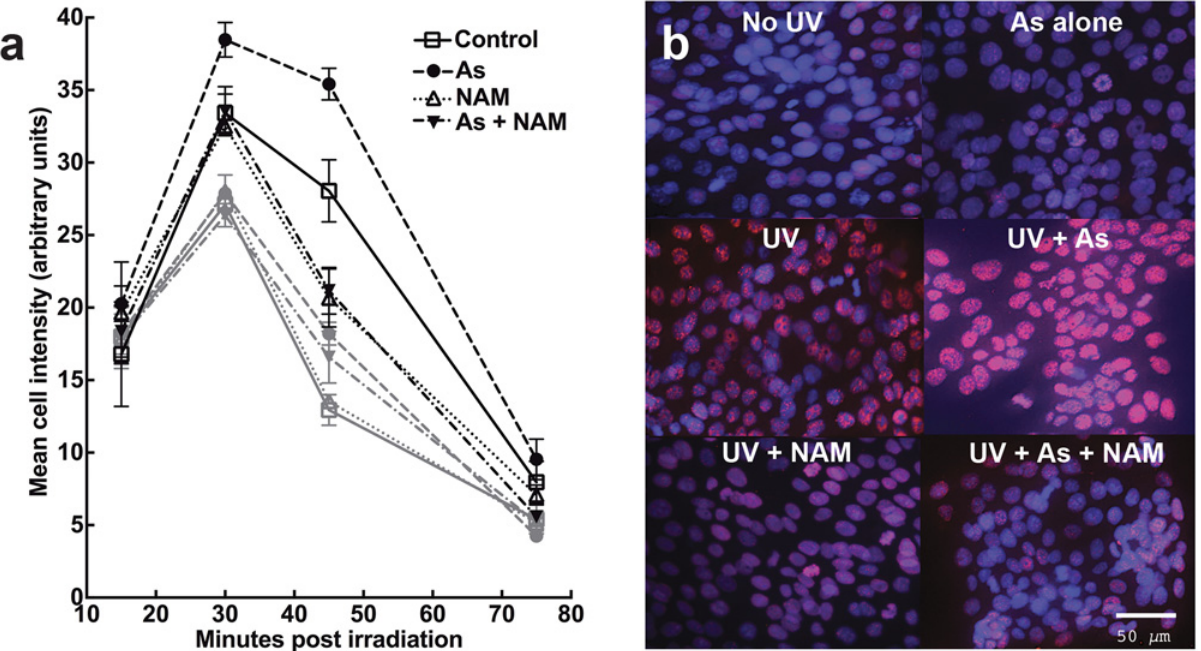
Fig 3. Nicotinamide (NAM) reduced arsenic- (As) and UV-induced 8oxoG in HaCaT keratinocytes (a). HaCaT keratinocytes were exposed to either 50 μ M nicotinamide, 2 μ M sodium arsenite, both sodium arsenite and nicotinamide or PBS (control) alone, with or without UV. Grey lines represent unirradiated groups. The mean of each timepoint is displayed ± SEM (n = 3). Significant differences included UV versus (vs) no UV (p < 0.05), UV vs UV + As (p < 0.01), UV vs UV + NAM (p < 0.05) and UV + As vs UV + As + NAM (p < 0.05) two way ANOVA. Staining of 8oxoG 45 minutes following UV radiation and arsenic exposure in HaCaT keratinocytes (and in unirradiated keratinocytes) shows reduced 8oxoG in irradiated, nicotinamide treated cells (b) . The blue staining represents DAPI (nuclear staining). The red staining represents 8oxoG